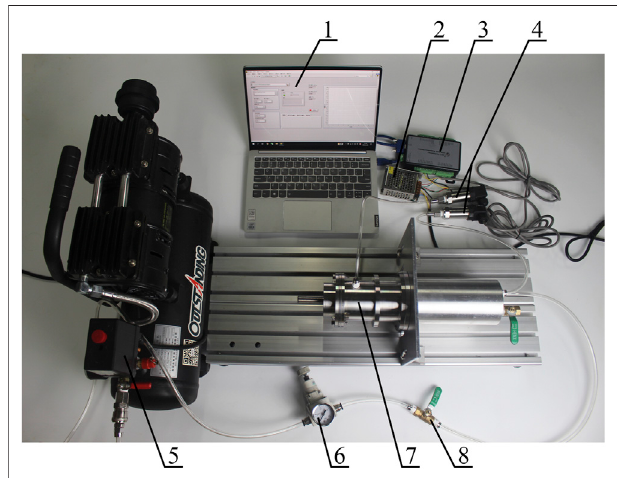
FIGURE 5 | Key components of the sealing prototype (1-gas chamber, 2-shell with bearings inside, 3-inner sleeve, 4-shaft, 5-magnetic unit, and 6- end cover).